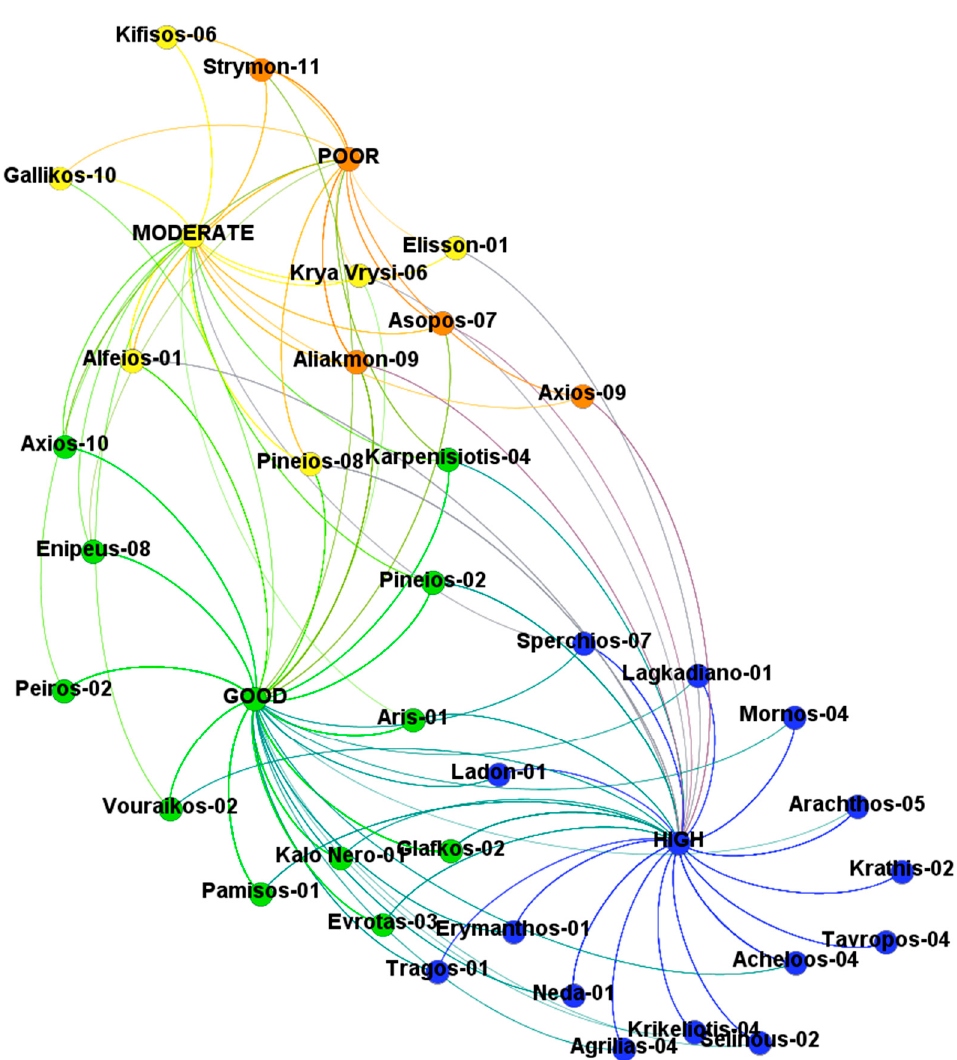
Figure 6. Network analysis of the main Greek rivers based on the physicochemical quality classification–Only rivers with more than nine (9) sampling efforts are included.